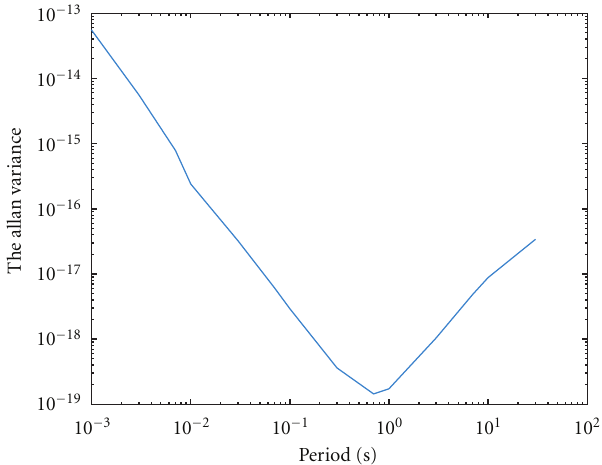
Figure 10: Absolute variance representing the accuracy with respect to the synchronization